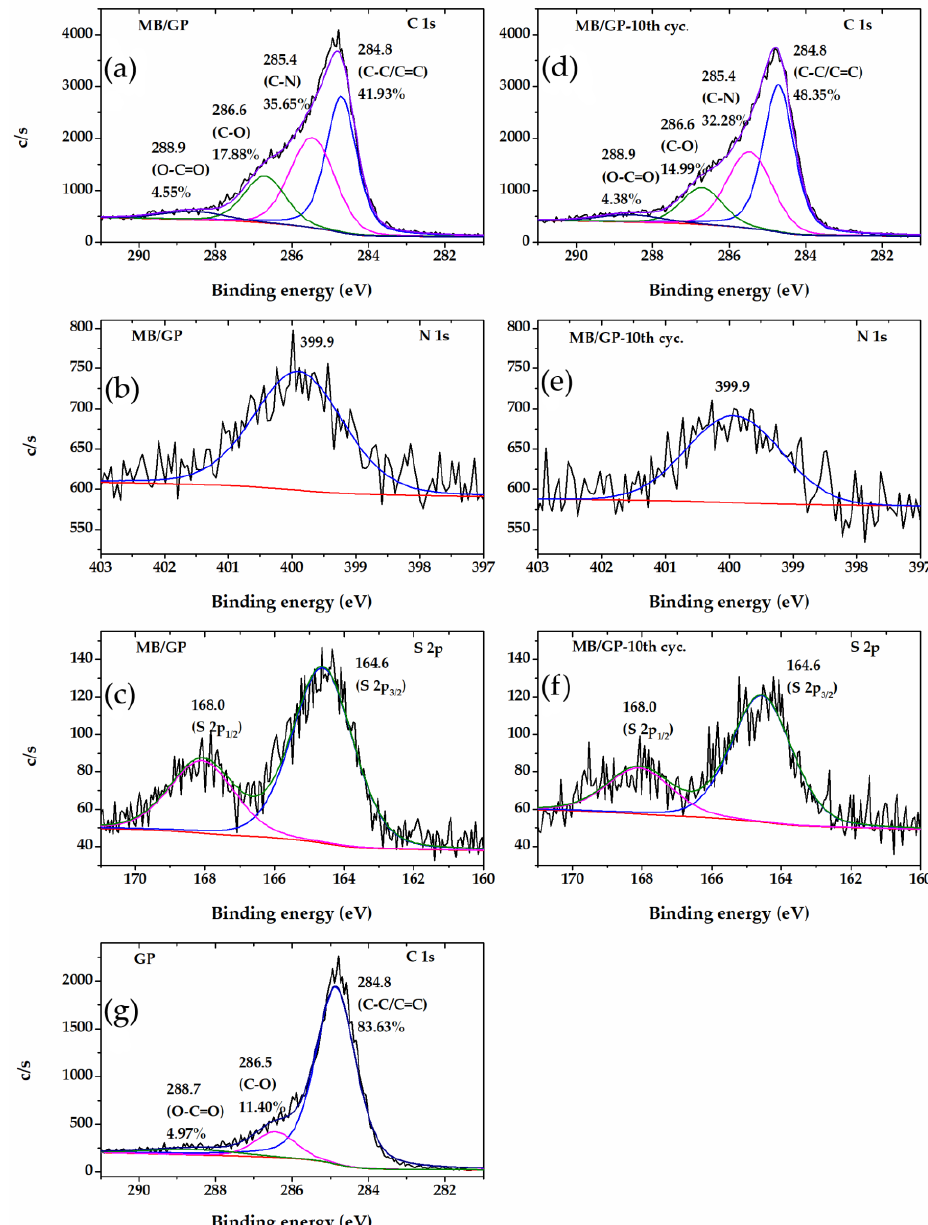
Figure 3. The XPS spectra of MB/GP ( a ) C 1s, ( b ) N 1s, ( c ) S 2p, MB/GP at 10th cycle of CV scan ( d ) C 1s, ( e ) N 1s, ( f ) S 2p, and GP ( g ) C 1s. Graphene is a honeycomb-shaped single atomic layer of SP 2 -hybridized carbon